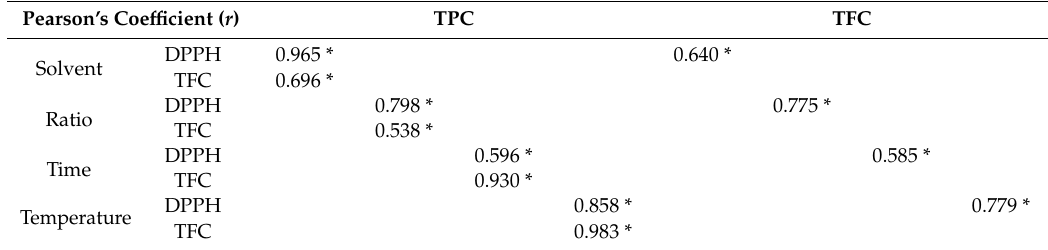
Pearson’s coe ffi cient of polyphenolic content and antioxidant activity at di ff erent ultrasound-assisted extraction